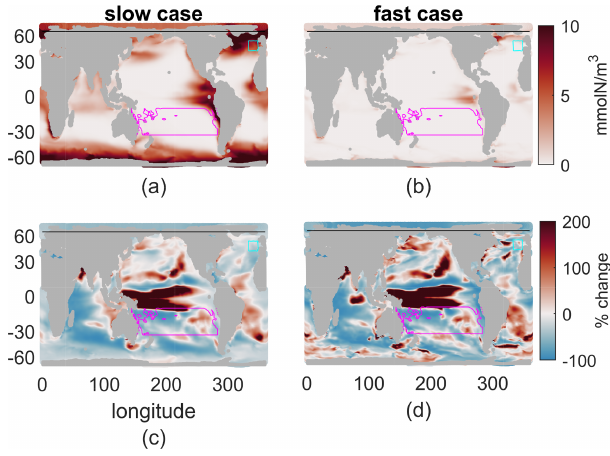
Figure 5. (a, b) Nutrient concentration, mmolN/m 3 , averaged over a year and the top 100m. (c, d) Percent change of this field from 2000s to 2100s climate. (a, c) Slow case. (b, d) Fast case. they are r = 0 . 88 and r = 0 . 48, respectively. Across our